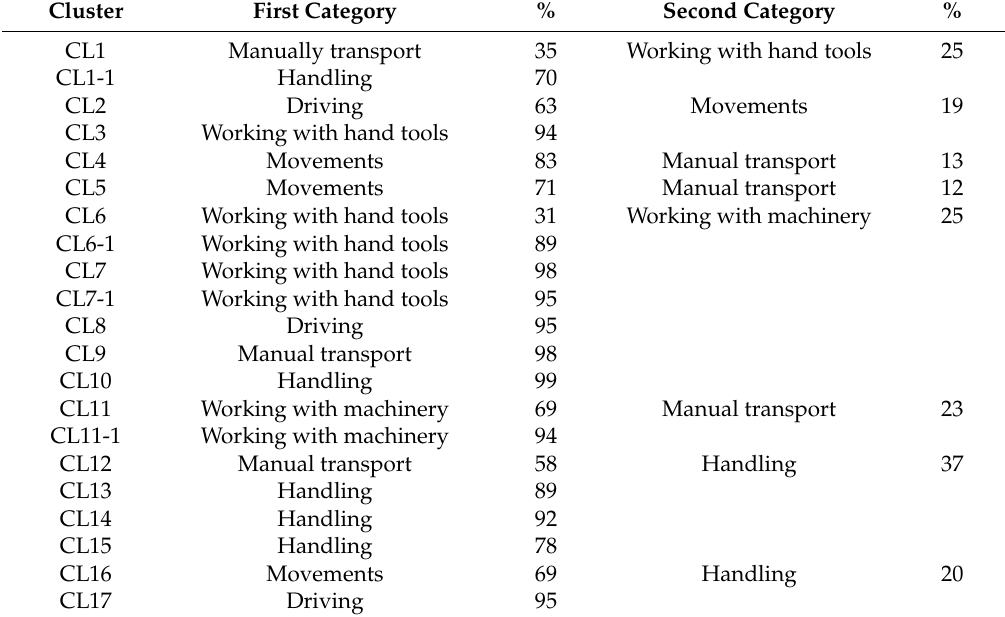
Table A2. Clusters description (Activity).